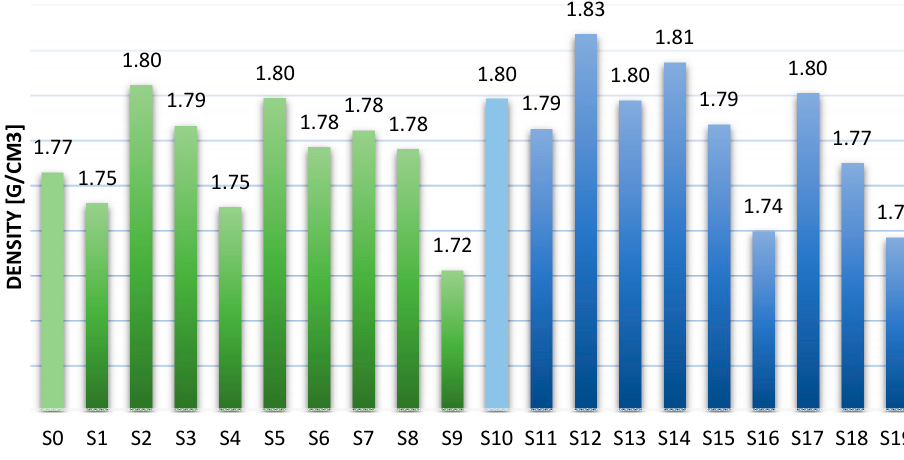
Figure 1. Density test result.